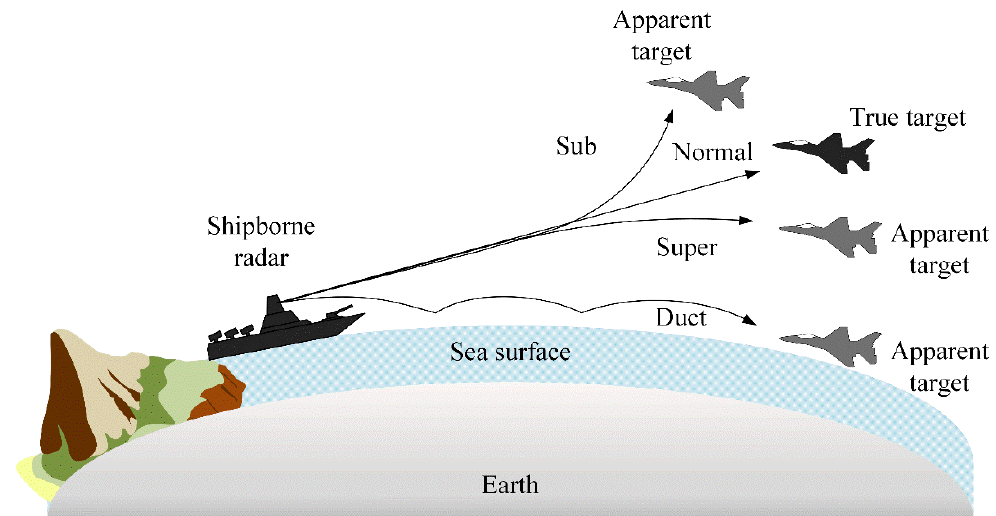
Figure 1. Wave propagation of the shipborne radar according to atmospheric conditions.